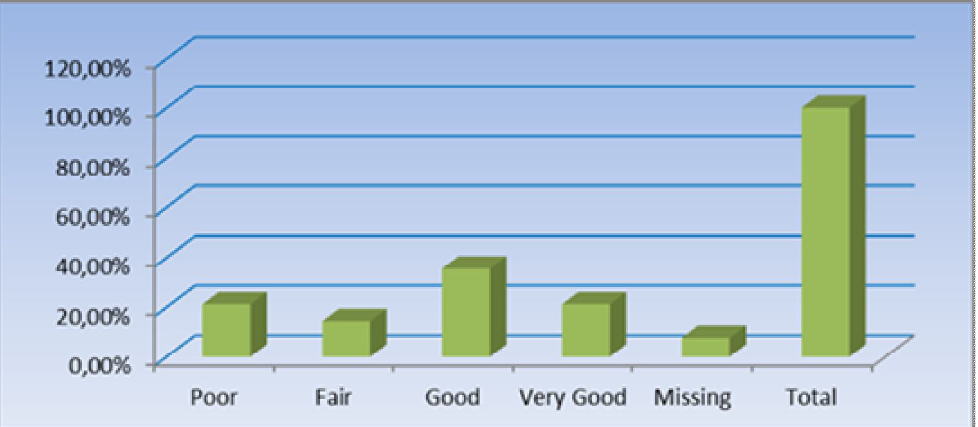
Figure 5: Respondents’ relationship with the lender